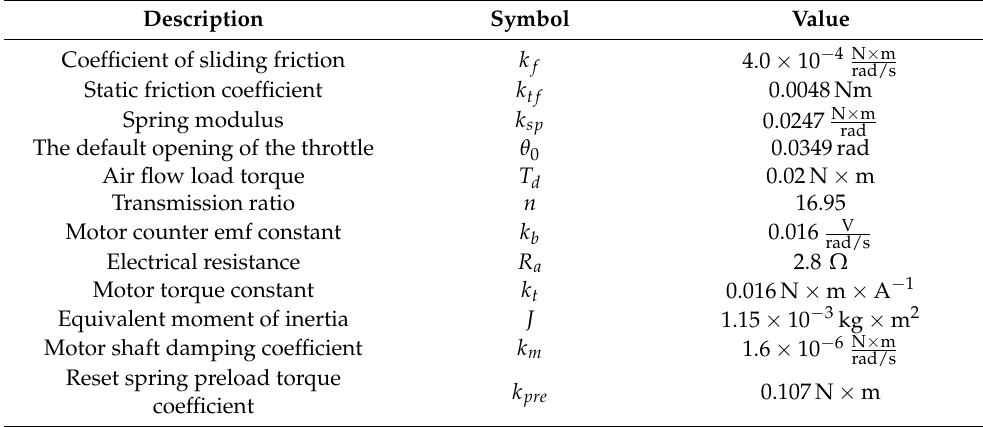
Table 2. Throttle Model